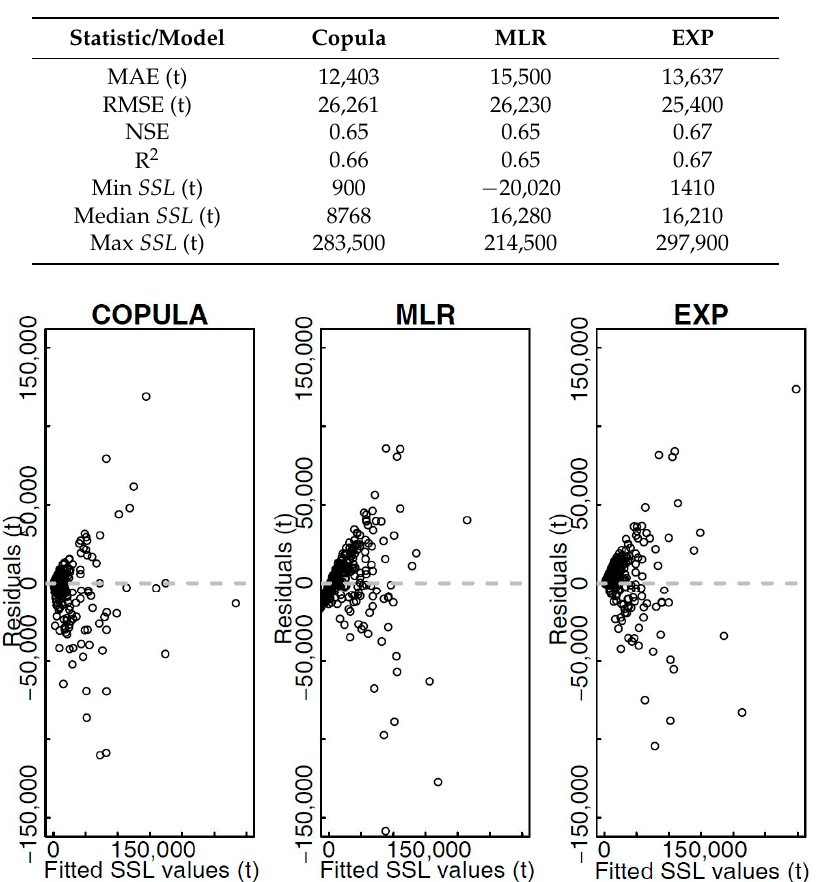
Figure 8. Diagnostic plots showing residuals versus fitted values for three tested models (Copula, EXP and MLR) for the Gornja Radgona station on the Mura River where for the EXP and MLR models the original data is used.